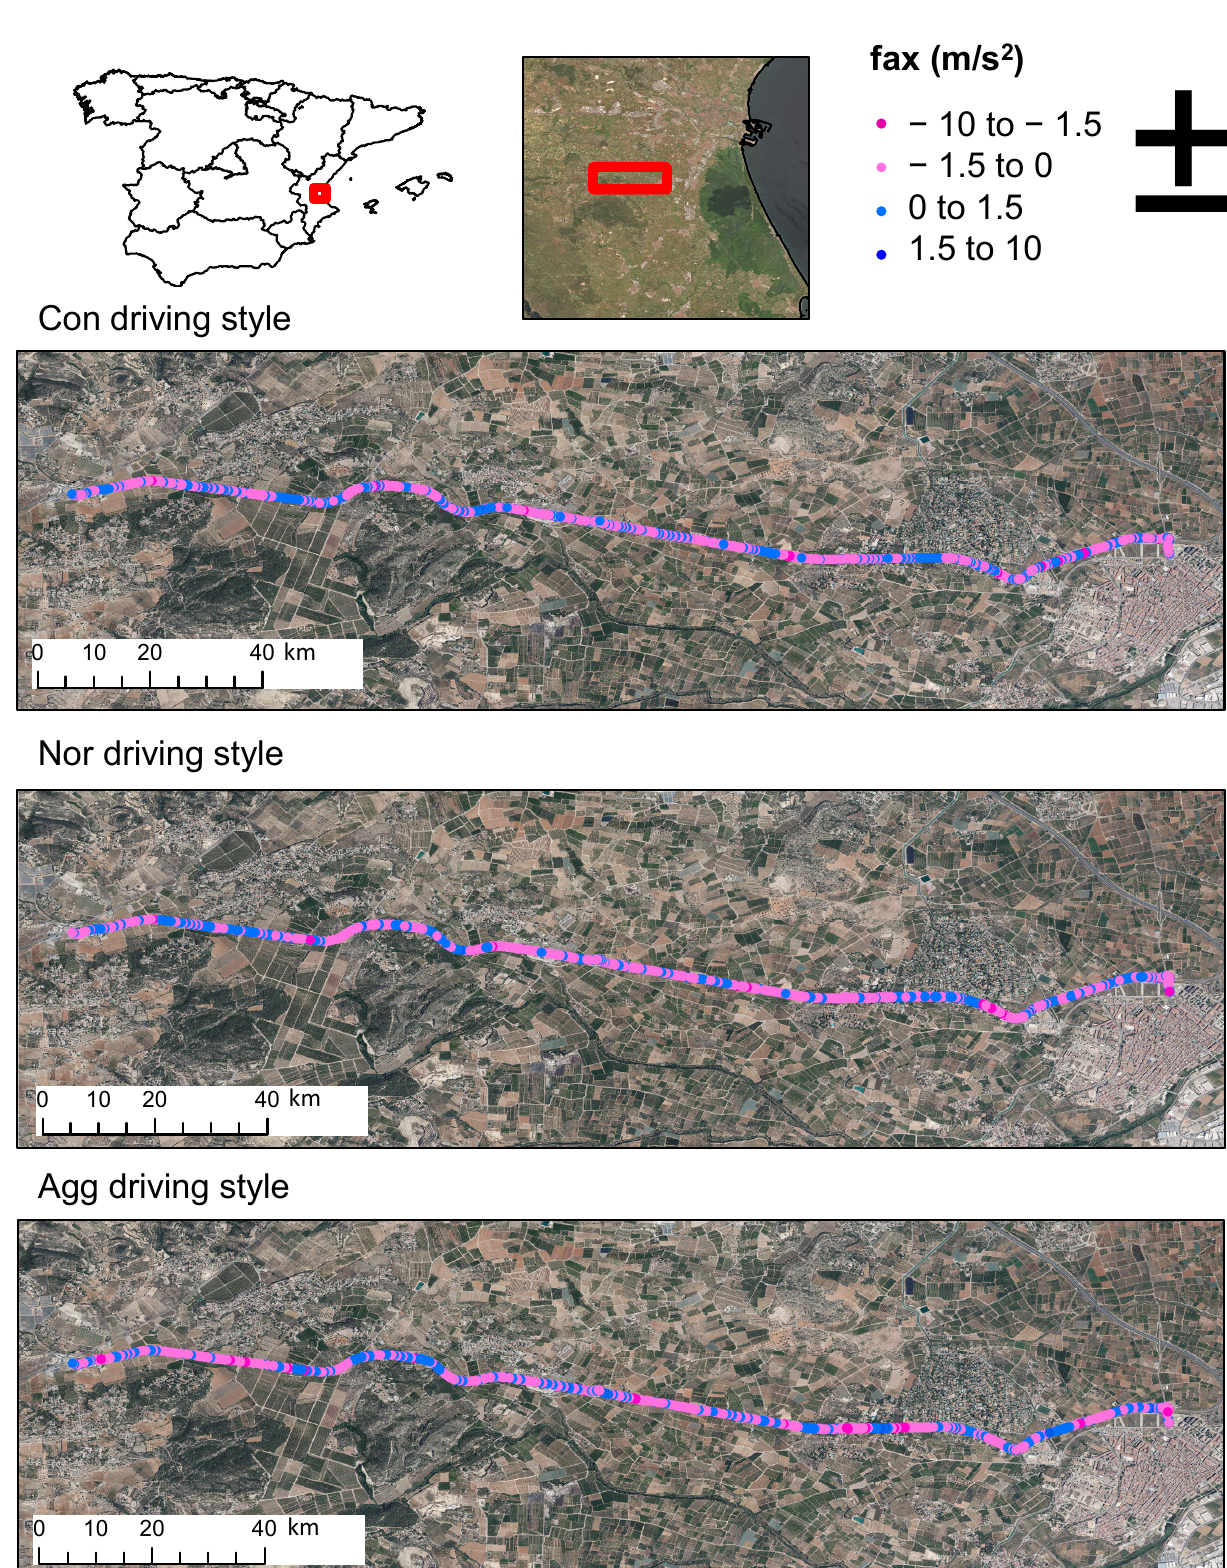
Figure 9. Variation of fax along the route for the three driving patterns.